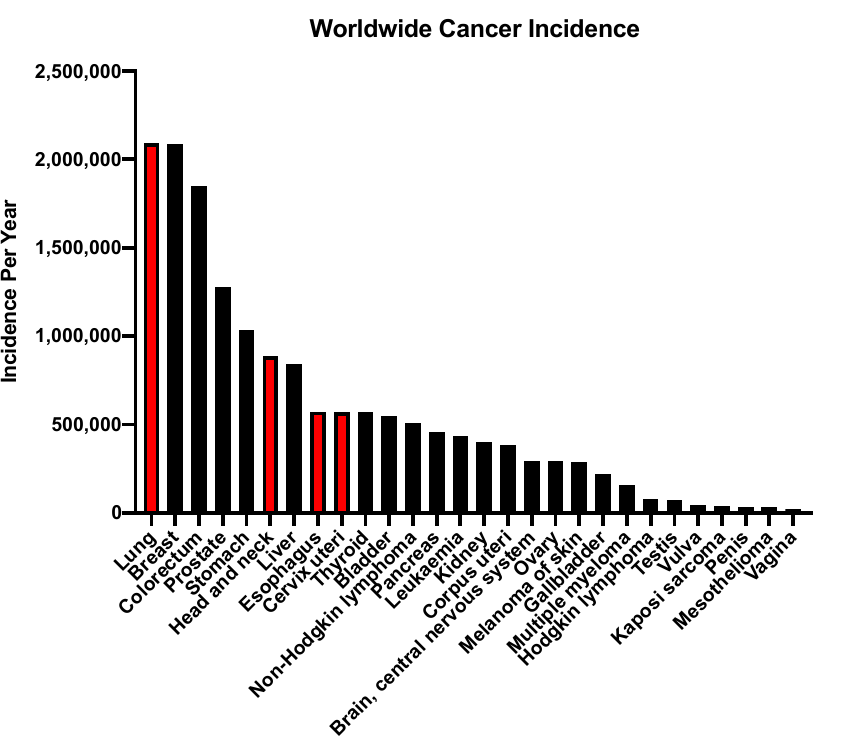
Figure 1. Worldwide incidence of the major types of human cancers. Red bars indicate cancers that have a squamous cell carcinoma (SCC) subtype. Data acquired from GLOBOCAN 2018. Within both HPV+/ − SCC tumors, a unifying genetic alteration in >75% of clinical